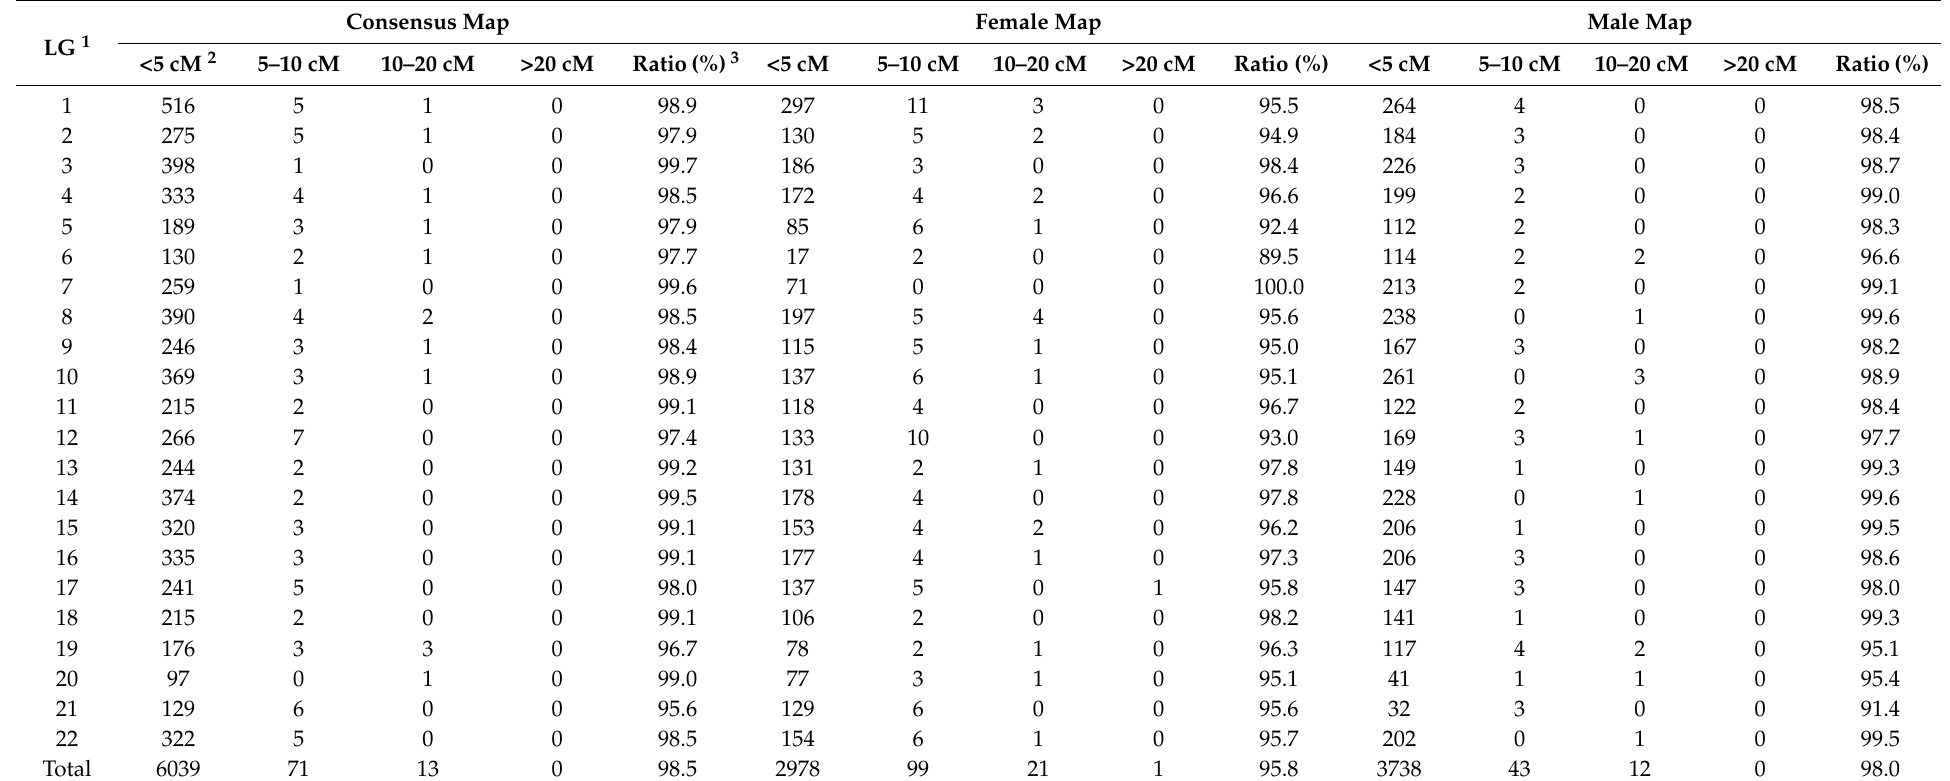
Table 2. Summary of the marker distance gaps (cM) per LG for A. japonicus